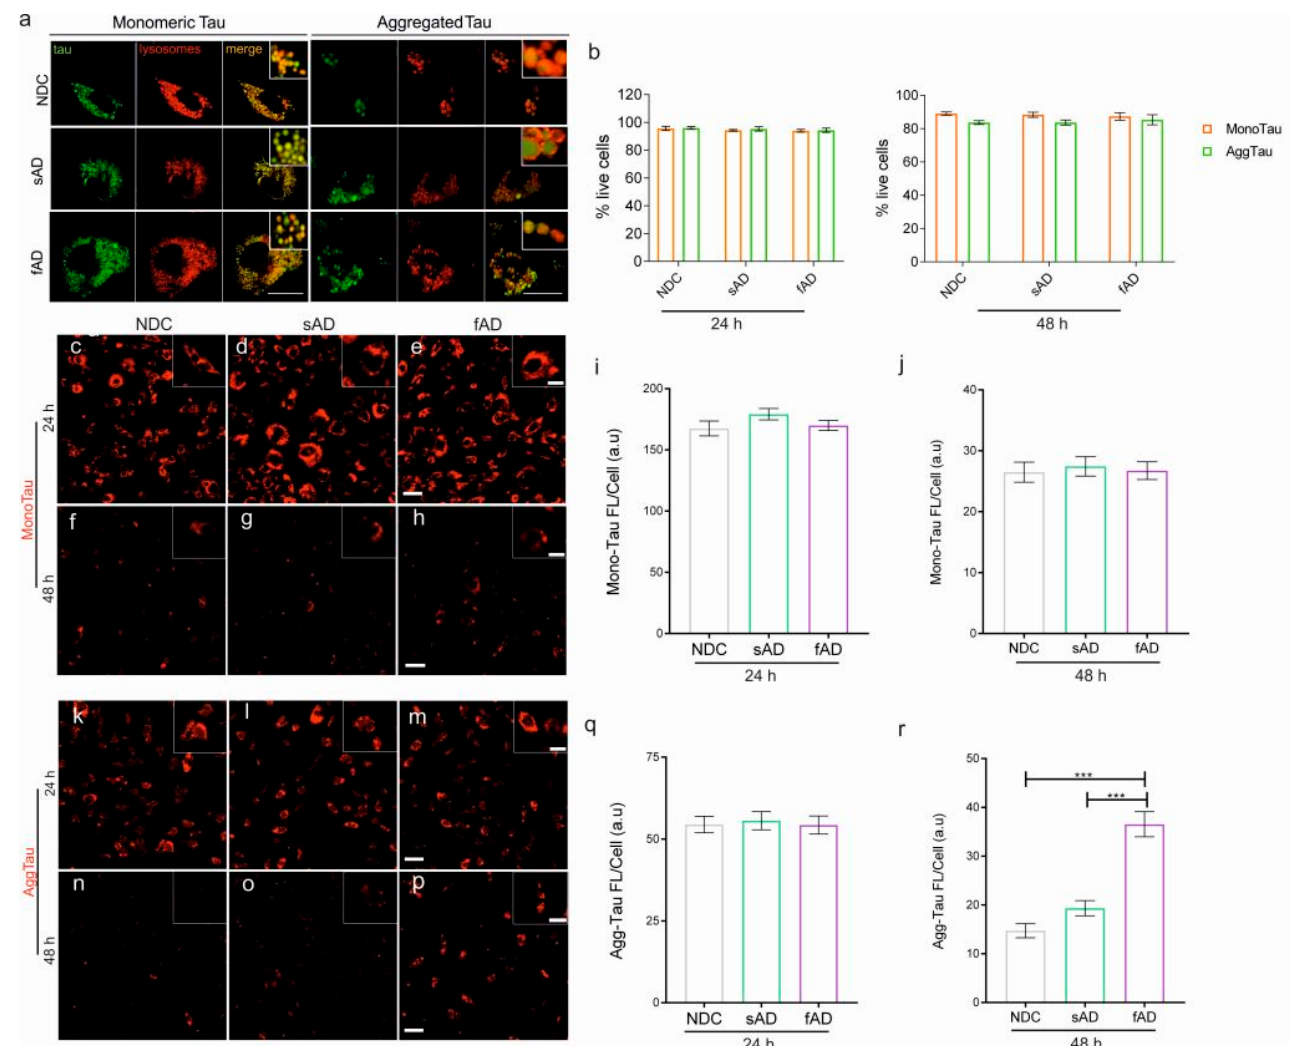
Figure 4. Astrocytes derived from fAD differently degrade monomeric and aggregated tau in vitro. ( a ) Bioimaging revealed the presence of monomeric and aggregated tau in the lysosomal compartment in all clones. Scale bar: 20 µm. ( b ) Graph showing percentage of viable astrocytes from NDC, sAD and fAD after exposure to monomeric or aggregated tau at 24 and 48 h. Bio-imaging of tau uptake by ( c ) NDC, ( d ) sAD and ( e ) fAD astrocytes 24 h after incubation with Alexa 546-conjugated monomeric tau. Representative live cell images of ( f ) NDC, ( g ) sAD and ( h ) fAD astrocytes at 48 h after removal of media containing monomeric tau (at 24 h). Graph showing mean fluorescence intensity of tau within the astrocytes at ( i ) 24 h and ( j ) 48 h, respectively. Bio-imaging of tau uptake by ( k ) NDC, ( l ) sAD and ( m ) fAD astrocytes 24 h after incubation with Alexa 546-conjugated aggregated tau. Representative live cell images of ( n ) NDC, ( o ) sAD and ( p ) fAD astrocytes at 48 h after removal of media containing aggregated tau (at 24 h). Note the drastic decrease in fluorescence intensity in the NDC and sAD astrocytes, and the accumulation of AggTau in astrocytes from fAD iPSCs at 48 h. Graph showing fluorescent intensity/cell of aggregated tau uptake at 24 h ( q ), and levels of aggregated tau at 48 h ( r ). One-way ANOVA followed by Tukey’s multiple comparisons tests was used for statistical analysis, ( n = 3/group; n = 3 experimental repeats). *** p < 0.0001. Scale bar: 50 nm; inset: 20 nm.